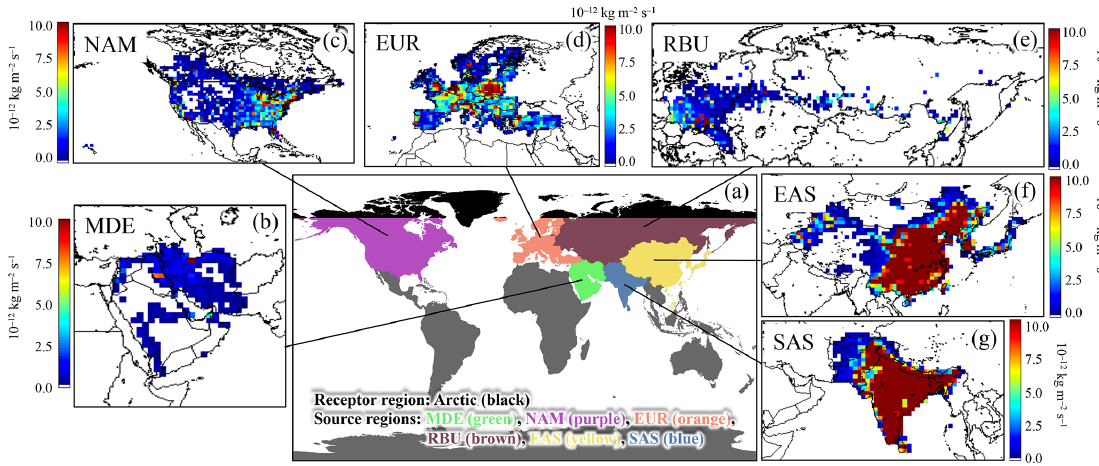
Figure 1. (a) The sketch map of receptor and source regions. (b–g) Spatial distributions of 20% reduction in annual BC emission in the six source regions in 2010. MDE: Middle East; EUR: Europe; RBU: Russia–Belarus–Ukraine; NAM: North America; EAS: East Asia; SAS: South Asia. The unit legends from (b) to (g) are the same (10 − 12 kgm − 2 s − 1 ). Table 1. Total anthropogenic emissions and 20% emission reductions in BC in different regions of HTAP2 in 2010 (unit:Ggyr − 1 ). Regions Total anthropogenic 20% emission reductions emissions Jan Feb Mar Apr May Jun Jul Aug Sep Oct Nov Dec 2010 EAS a 1778.1 46.4 35.6 33.0 EUR b